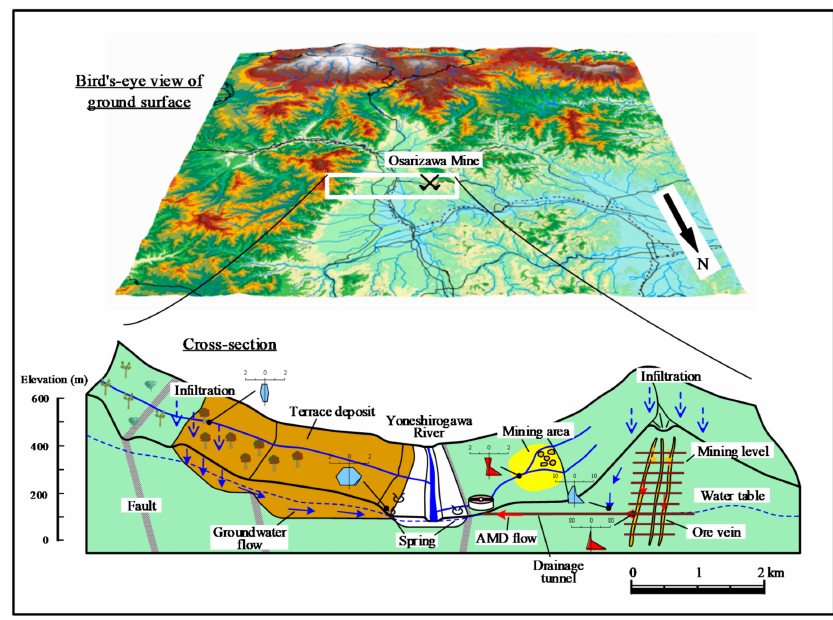
Figure 7. Conceptual model of discharge and groundwater flow from the Osarizawa Mine